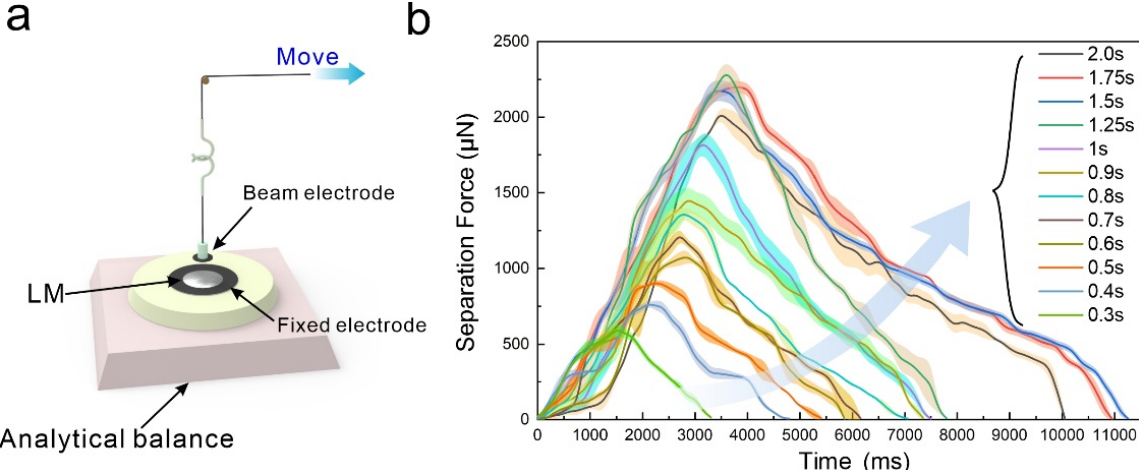
Figure A2. Method of the separation force measurement. (a) Schematic of the separation force measurement. The beam electrode is suspended above the fixed electrode by a thin wire. First, these two electrodes come into contact together. Then, the beam electrode rises slowly (0.25 mm/s), controlled by a precision stepper motor. During the rising process, the mass shown on the analytical balance will decrease due to the separation force between these two electrodes. Therefore, we can measure the separation force from the change in mass, and results are shown in (b) Separation force of different spray times of LM with different times.